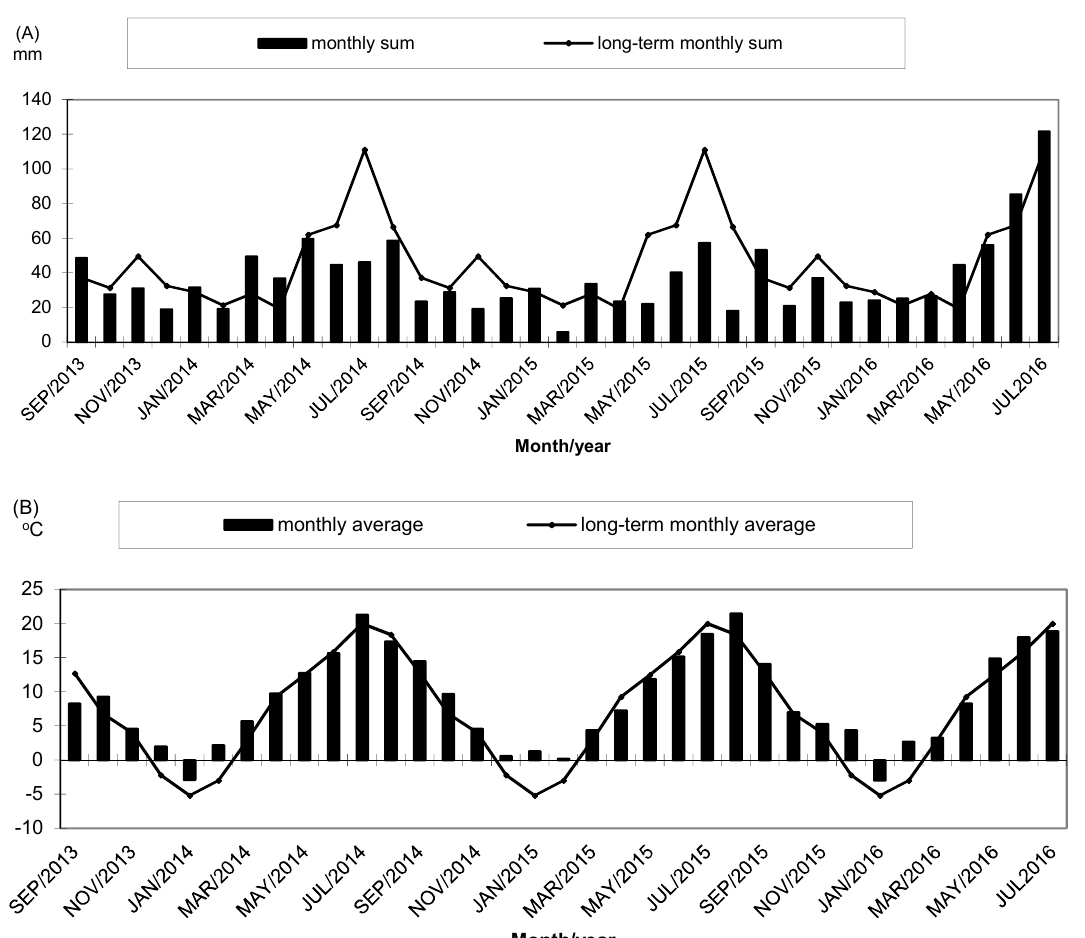
Figure 2. Precipitation ( A ) and air temperature ( B ) at the site of the field experiment.